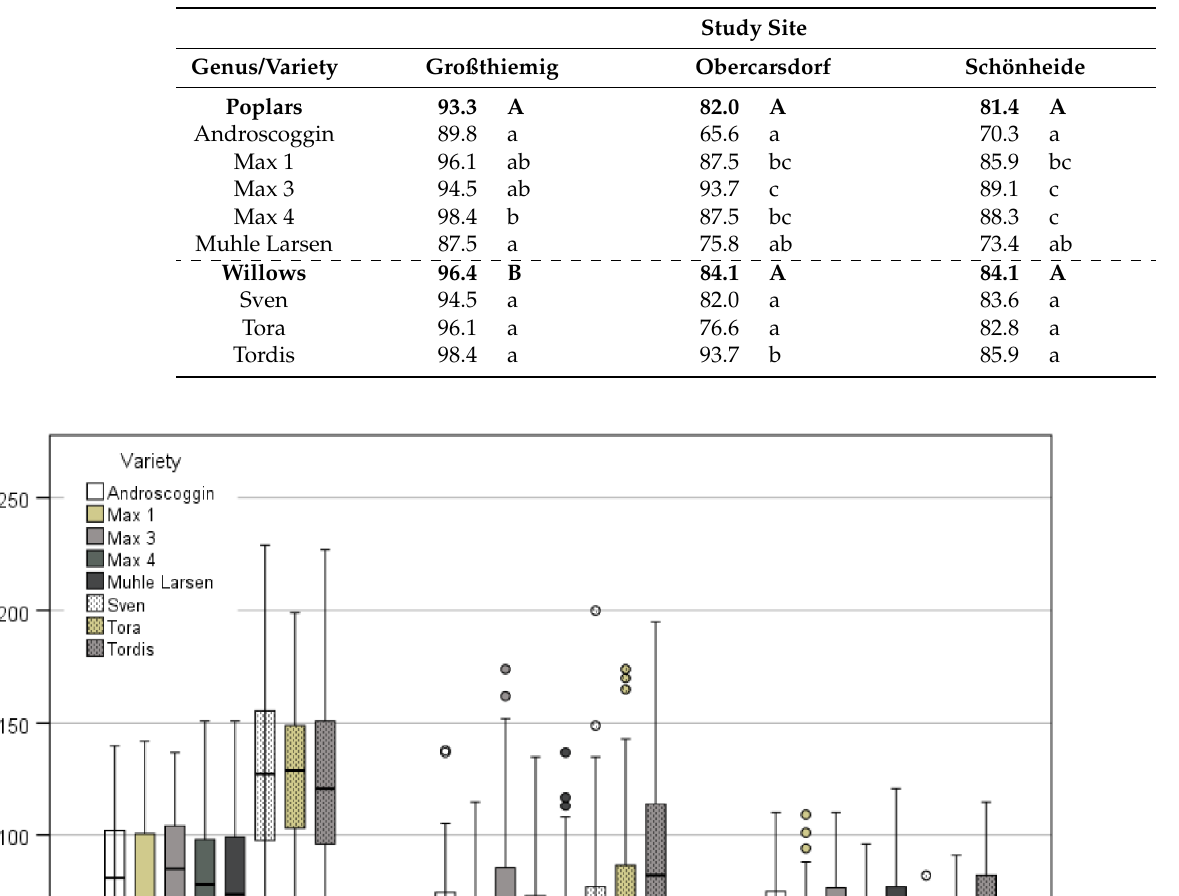
Table A1. Mean percentage of surviving plants on the three study sites in July/August 2007 four months after the establishment of the short rotation coppices (bold values indicate mean values of all varieties of a tree genus, different capital letters indicate statistically significant differences between tree genera, different small letters indicate statistically significant differences between varieties within tree genera).